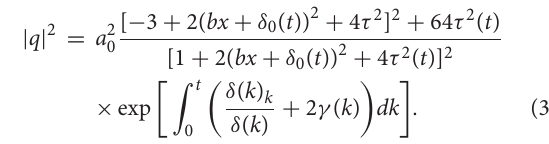
0.5 sech (0.2 t ) and δ 0 ( t ) =